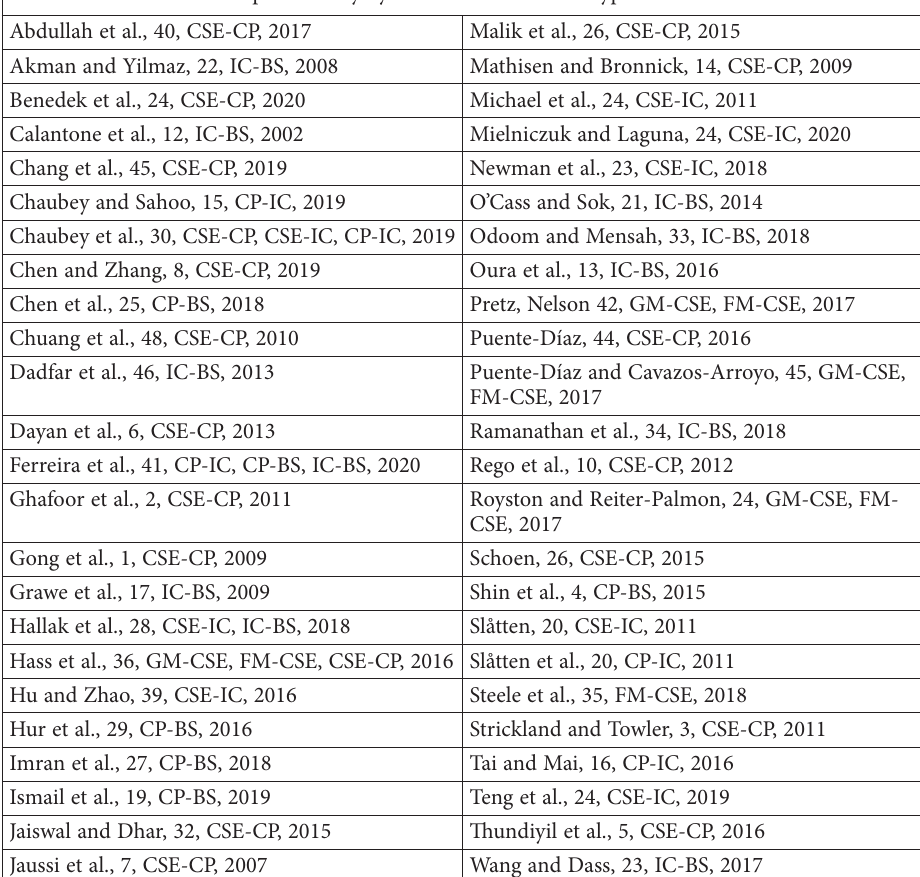
Table 1. Studies used in meta-analysis (source: created by authors) Studies alphabetically by source and codes for hypotheses tests a,